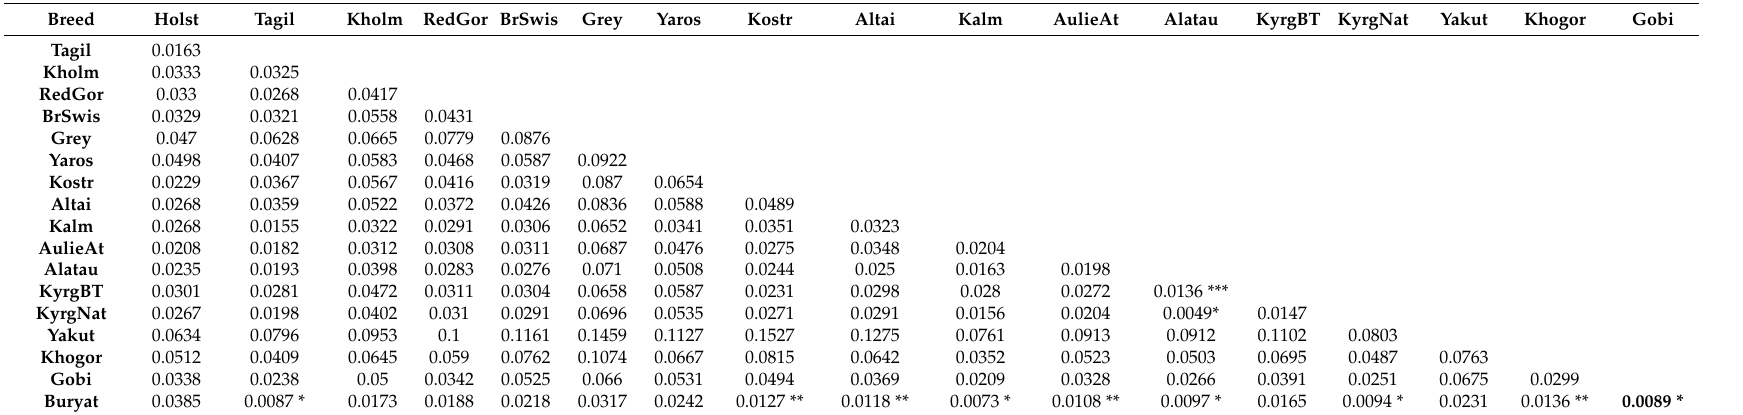
Table A4. Nei’s Pairwise Fst values among